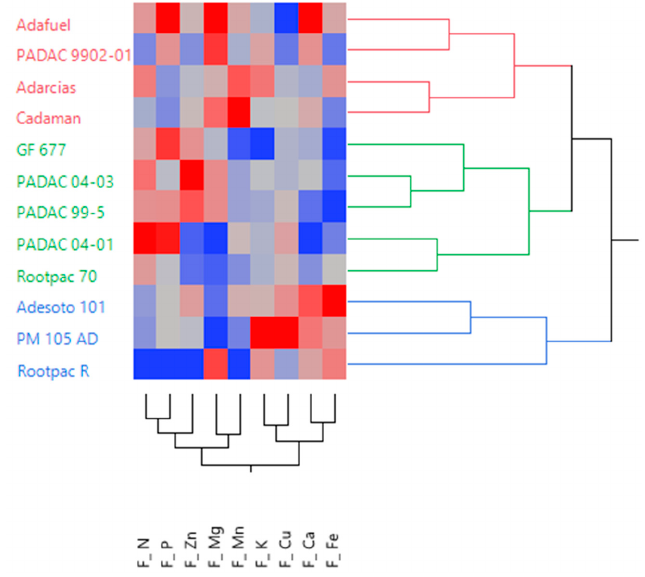
Figure 4. Rootstocks and flower nutrients grouped by similarities in mineral nutrient concentration mean values. Higher trait values are red whereas lower means are blue and average values are gray. Rootstocks labeled in red belong to Cluster 1, labeled in green to Cluster 2, and labeled in blue to Cluster 3.